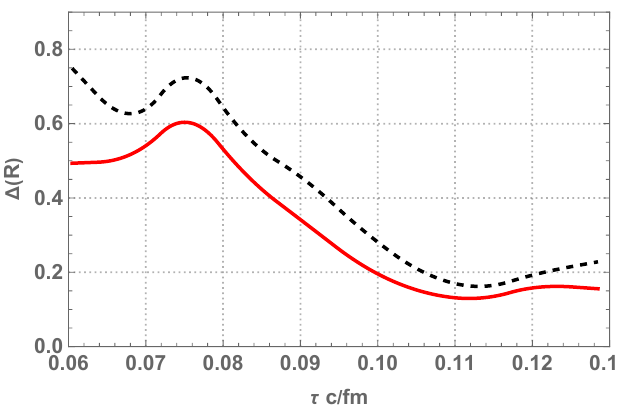
Figure 8 . The hydro residual ∆( R ) averaged over the region R as a function of proper time τ (black, dashed curve) and the median ∆ in the region R (red solid